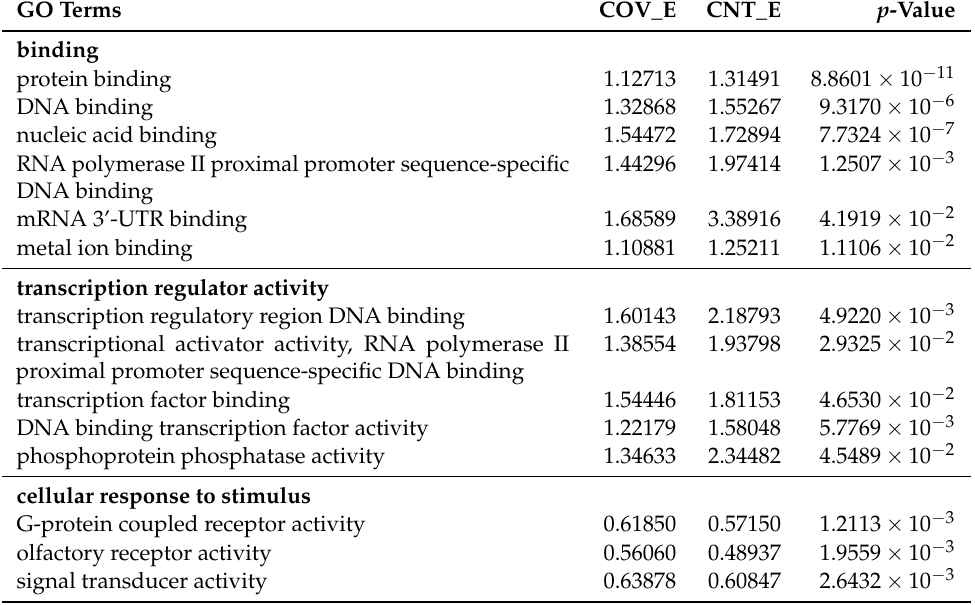
Table 2. Enrichment of high-confidence RNAz hits in the 3’-UTR for Gene Ontology (GO) terms describing Molecular Function. COV_E : Enrichment in terms of nucleotides coverage. CNT_E